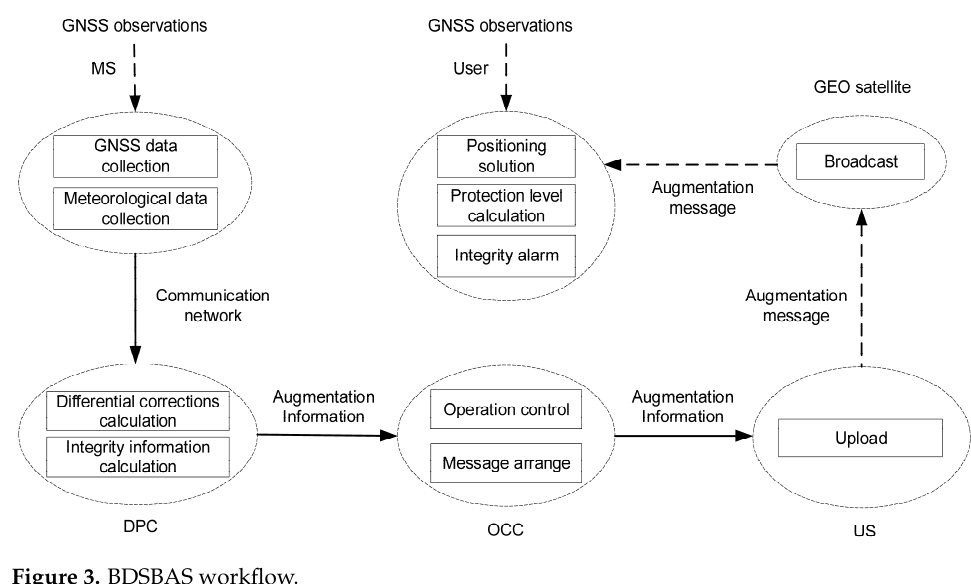
Figure 3. BDSBAS workflow.